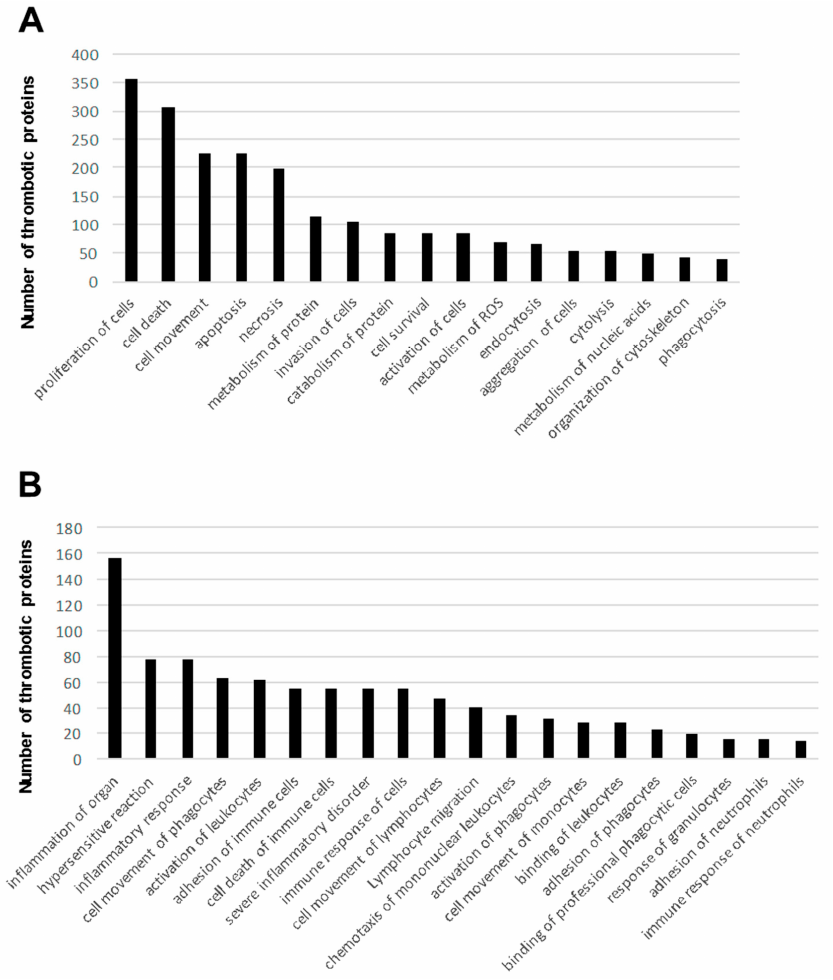
Figure 2. Generic ( A ) and immunological ( B ) functions significantly represented according to the thrombotic proteome characterized in this study (disease and functions from the global 1600 protein